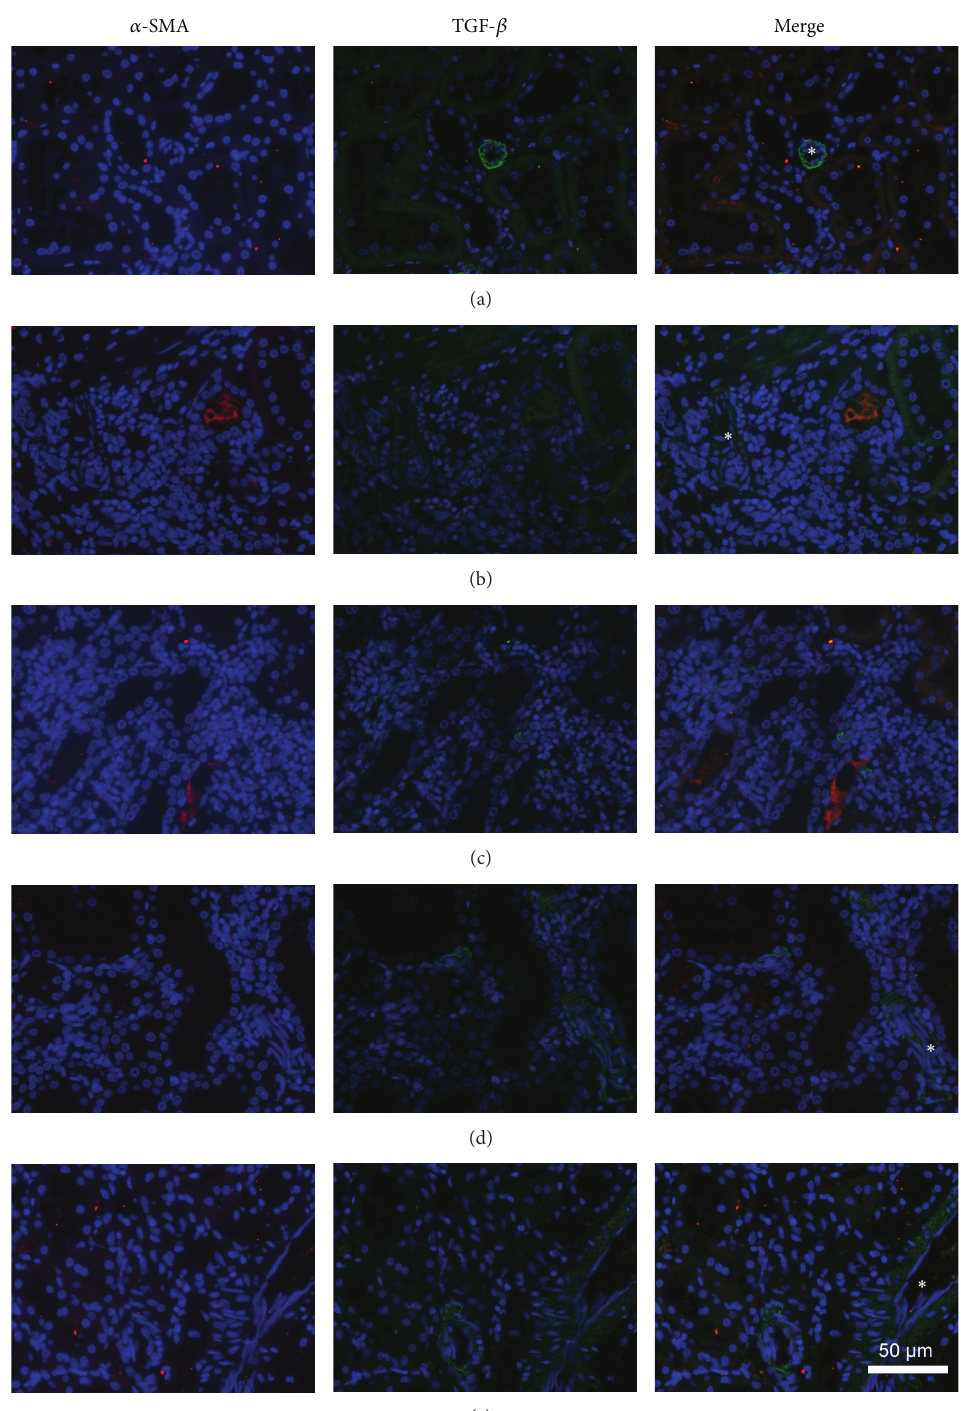
Figure 5: Immunofluorescence microscopy of 𝛼 -smooth muscle action and transforming growth factor- 𝛽 . Kidney tissue sections (4 𝜇 m) were stained with the activated fibroblast marker 𝛼 -smooth muscle action (green) and the profibrotic cytokine transforming growth factor- 𝛽 (red) and examined under a Zeiss A2 imaging microscope (Carl Zeiss, Hamburg, Germany). Both interstitial fibroblasts and vascular smooth muscle cells are positive for 𝛼 -smooth muscle action (green). Consistent with the immunostain of the phagocytic marker CD68 (Figure 4), inflammatory cells immunoreactive for transforming growth factor- 𝛽 (red) are predominantly interstitial large macrophages and frequently intermixed with infiltrating lymphocytes. (a) Normal control (CN); (b) model of diabetic nephropathy that never had any treatment (DN); (c) treatment with benazepril 10mg/kg/d (Ben); (d) treatment with irbesartan 30 mg/kg/d (Irb); (e) combined treatment with benazepril 10mg/kg/d and irbesartan 30 mg/kg/d (Ben and Irb). Original magnification, × 200; scale bar, 50 𝜇